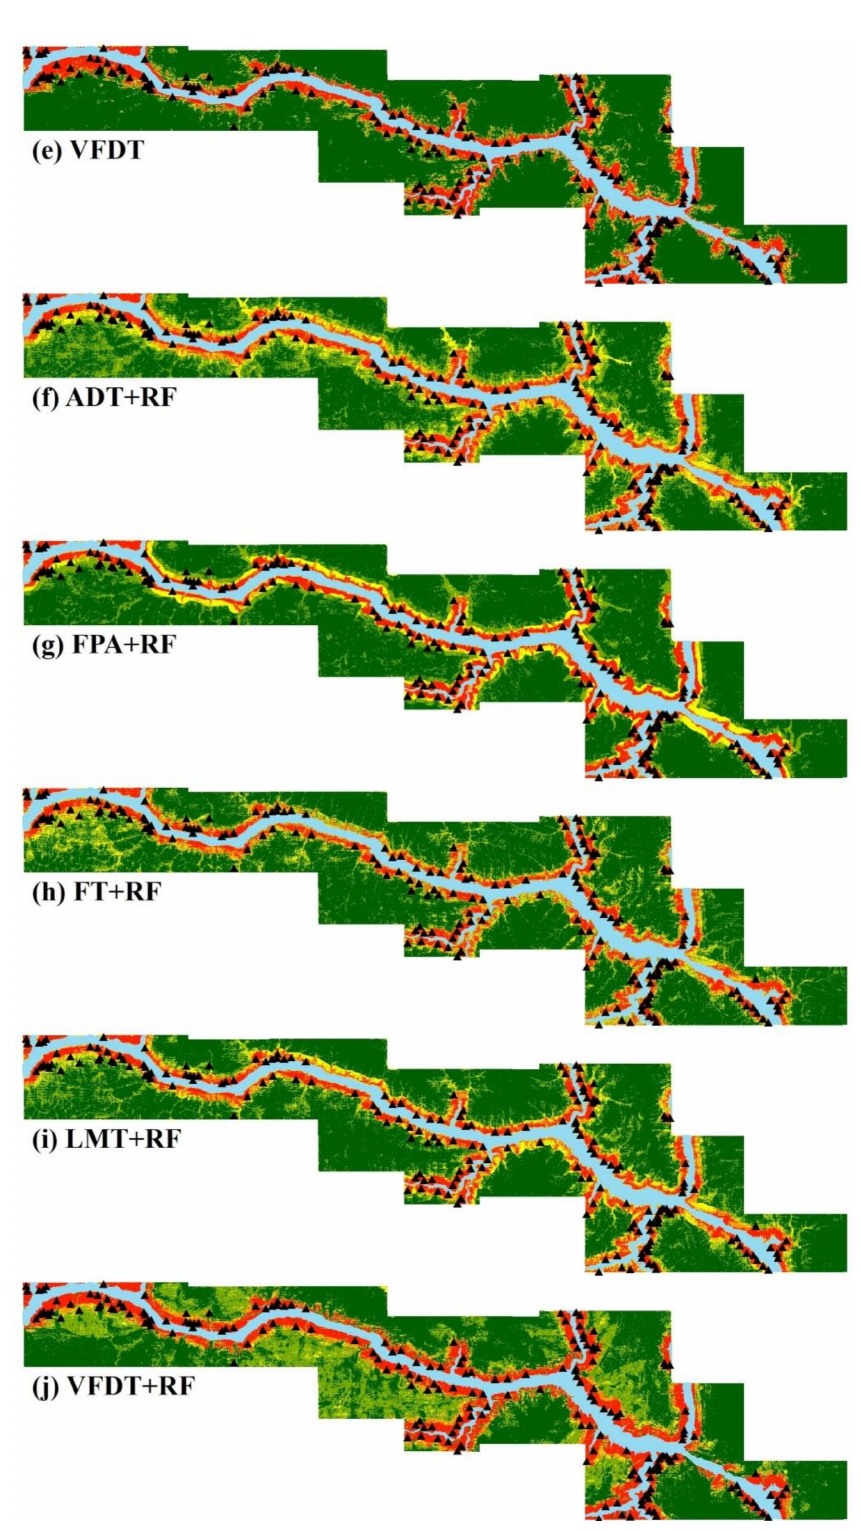
Figure 4. Landslide susceptibility maps of different prediction method. ( a ) ADT, ( b )